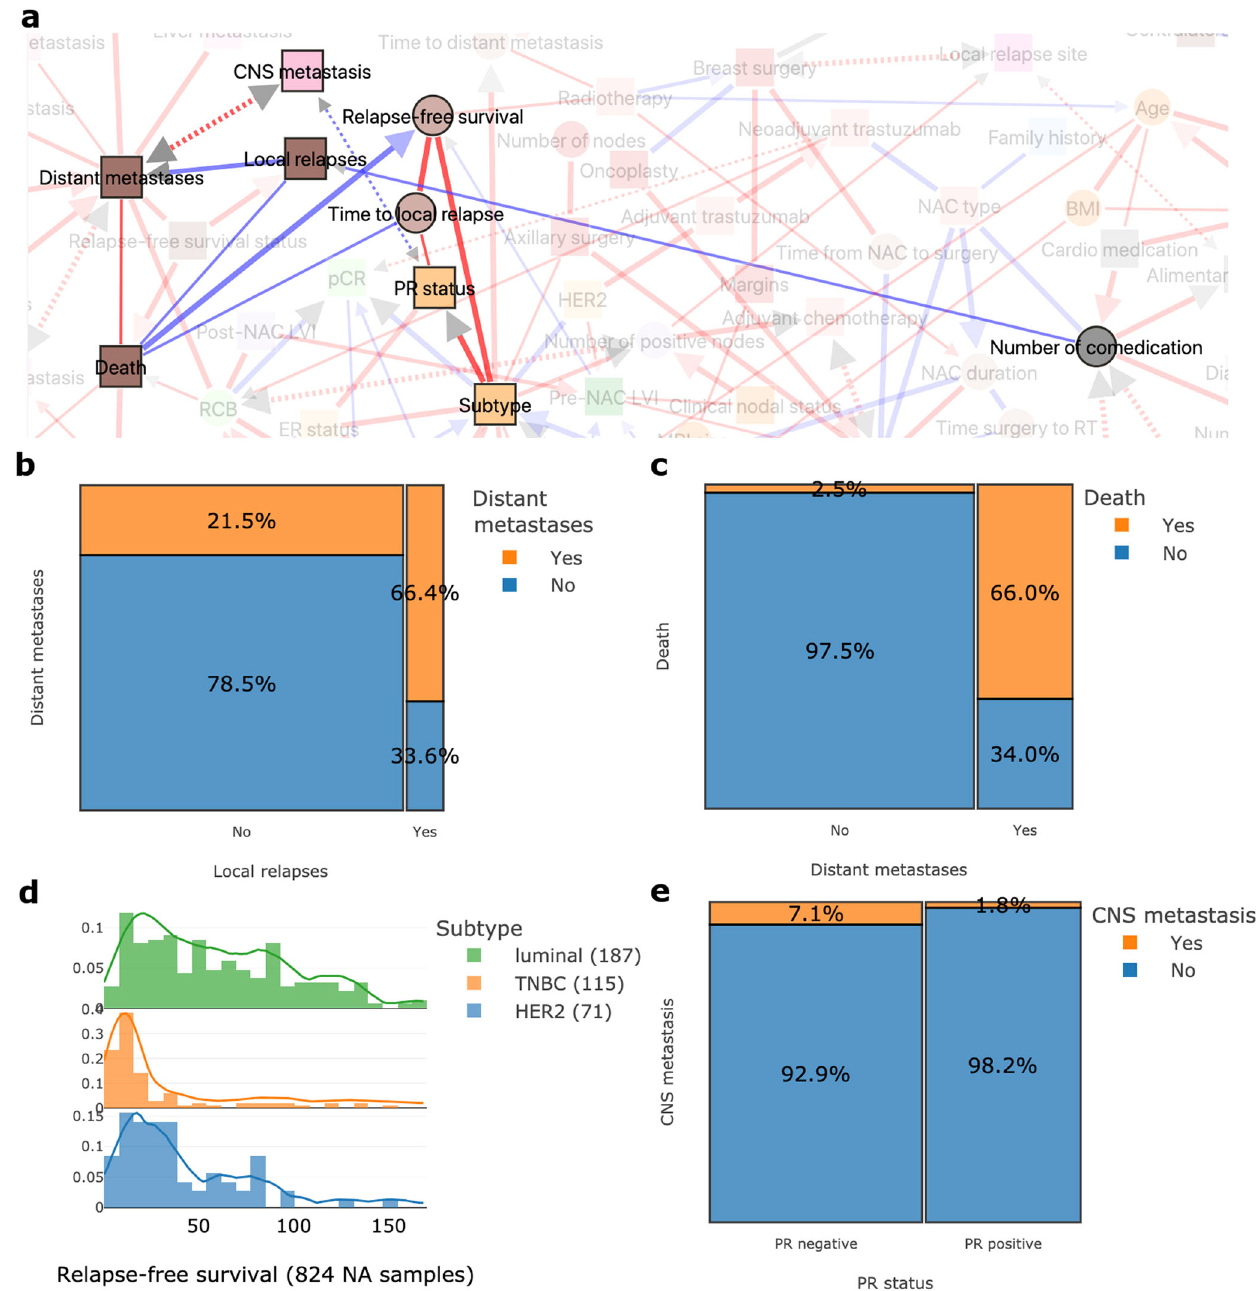
Fig. 4 MIIC traces the natural course of the disease. a Network interactions showing links between relapses, metastases and death in breast cancer. b Proportion of distant metastases according to the occurrence or absence of local relapses. c Proportion of deaths according to distant metastasis status. d Distribution plot for relapse-free survival (in months) according to breast cancer subtype. e Proportion plot displaying the relationship between central nervous system (CNS) metastasis and progesterone receptor (PR)